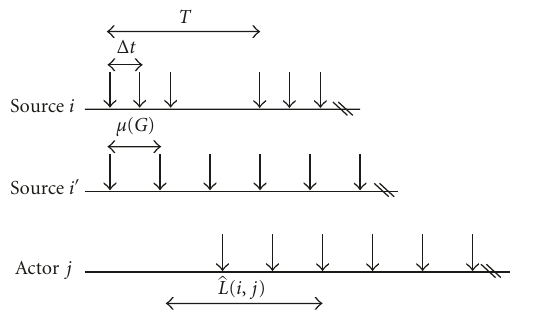
Figure 4: Arrival times of tokens of a bursty source relatively to strictly periodic